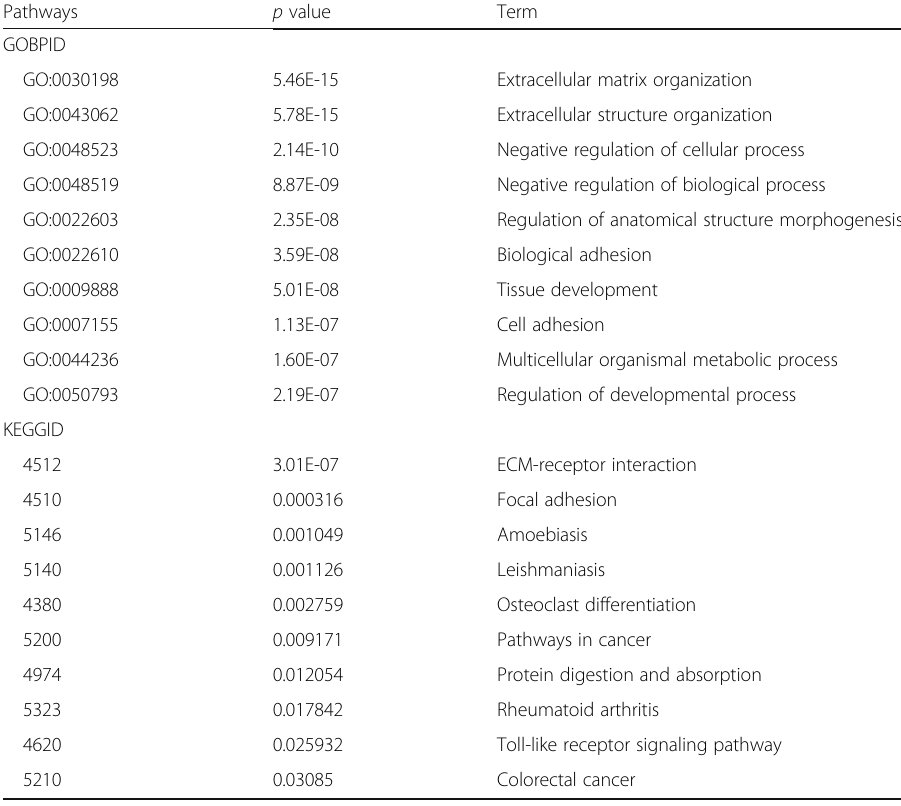
Table 2 The significant GO biological processes and KEGG pathways enriched by the common genes identified in breast cancer stromal cells Pathways p value